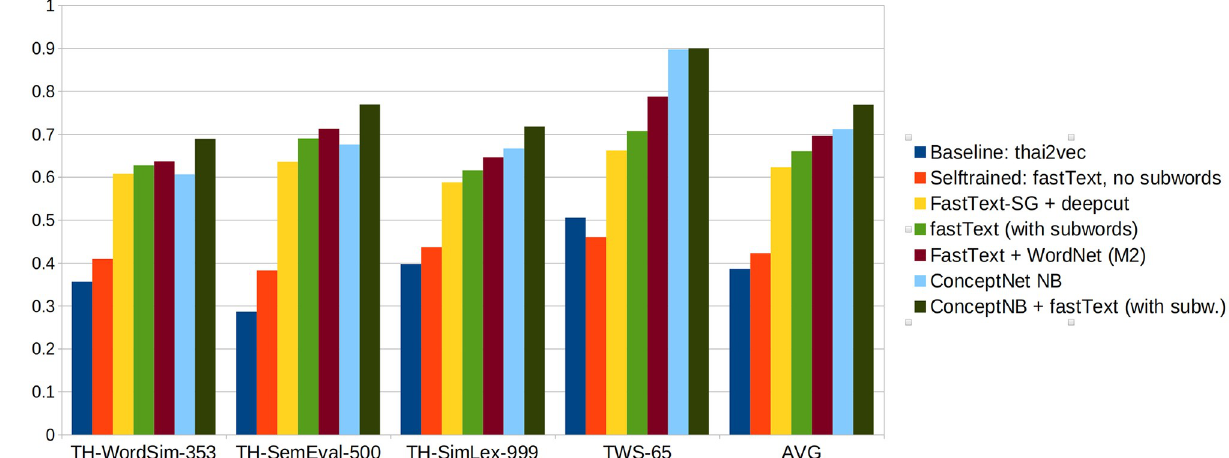
Fig 3. Overview of results. Comparing the baseline from previous work ( Baseline: thai2vec ) with the various approaches implemented in this work.